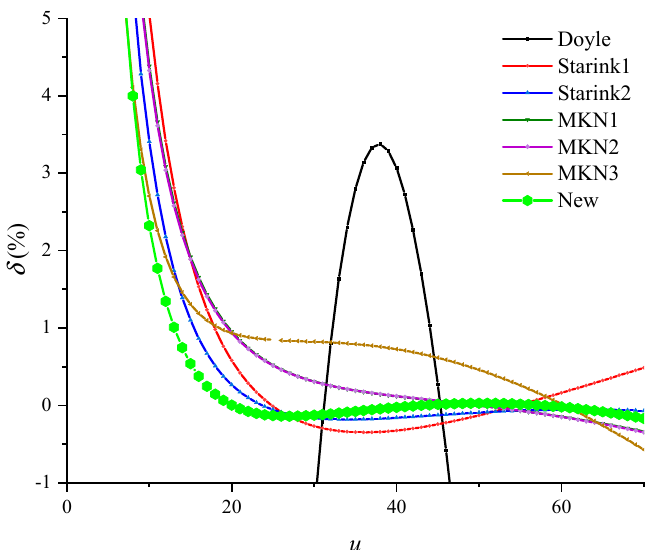
Figure 4. Percent deviation of the temperature integral approximation. Table 3. The value range of u for different temperature integral equation at typical percentage deviation.